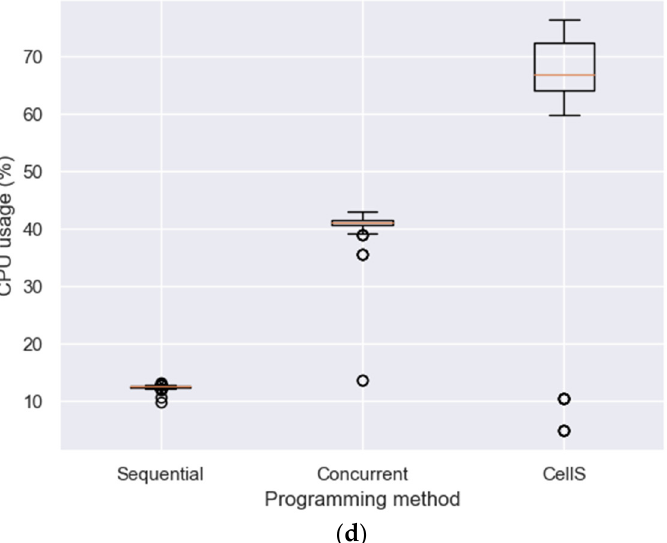
Figure 14. These are the experimental results of CPU usage in different programming methods: ( a ) 10 milliseconds/flow; ( b ) 30 milliseconds/flow; ( c ) 100 milliseconds/flow; and ( d ) 1000 milliseconds/flow.